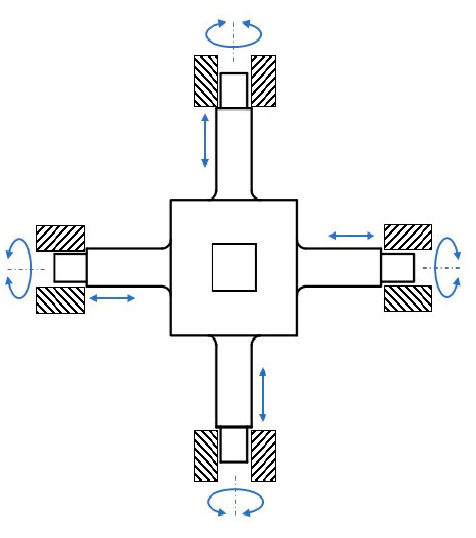
Figure 2. Sliding mechanism of the elastic body.